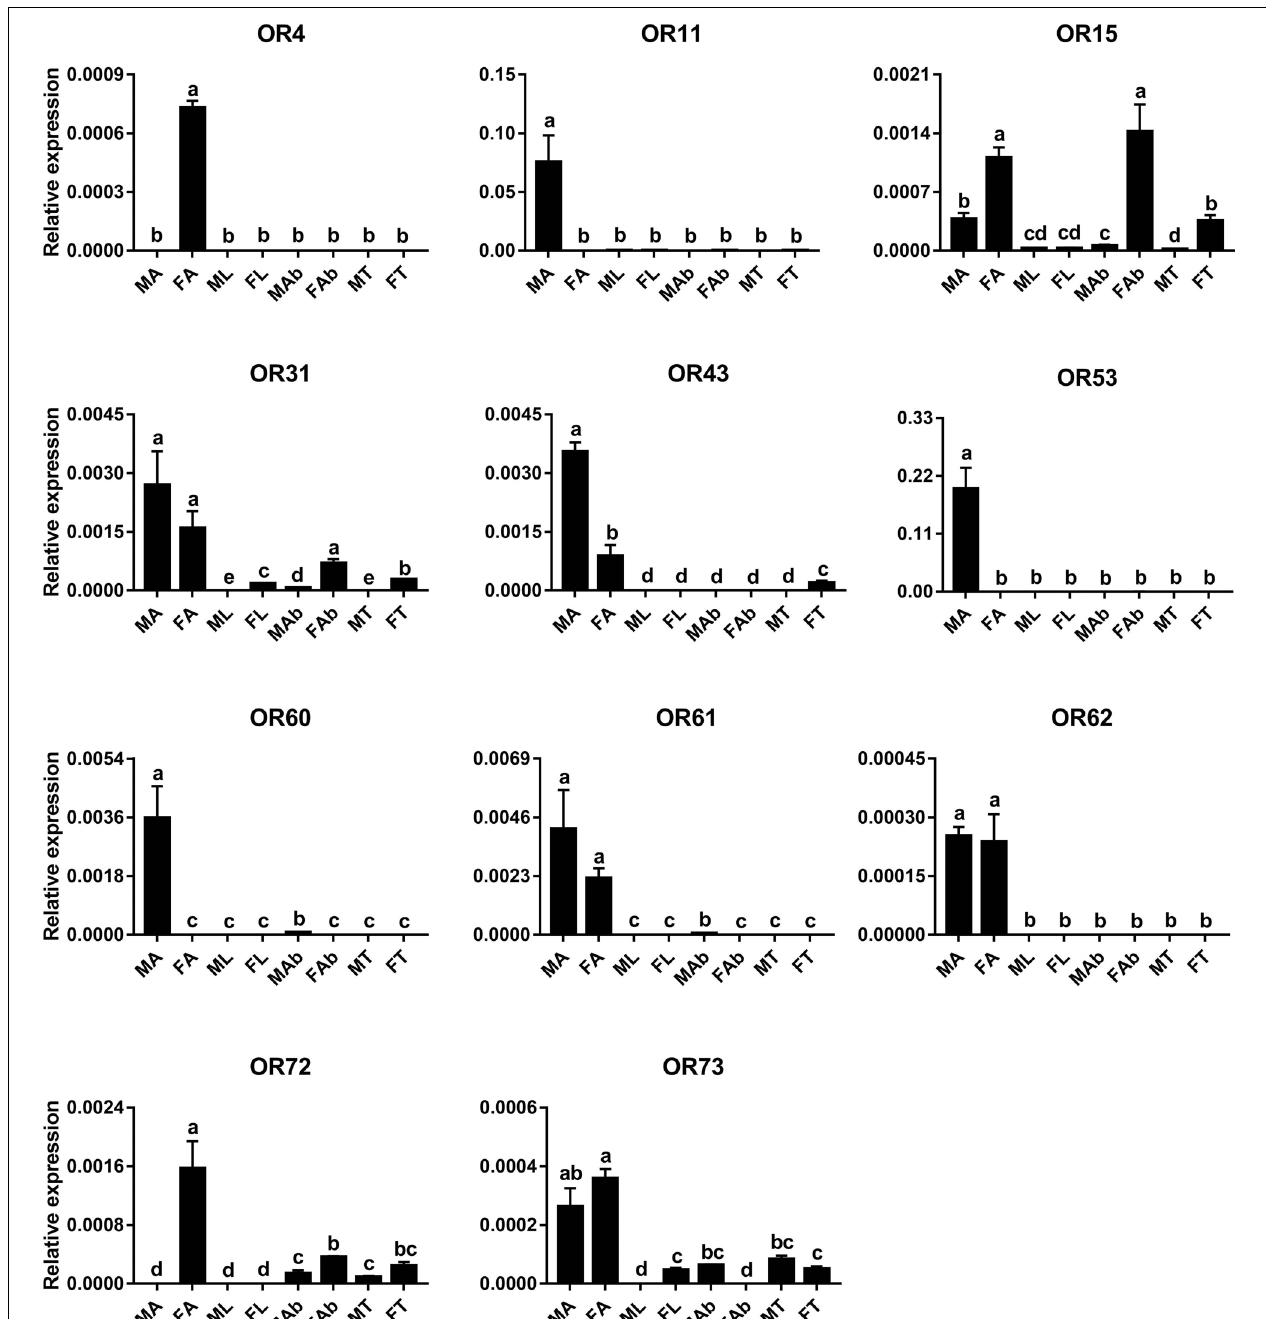
FIGURE 5 | Expression profile of candidate DabiPRs in different tissues of D. abietella . Significant difference of OR expression levels among tissues is indicated with different lowercase letters (ANOVA, LSD, P < 0.05). Relative expression of DabiORs was normalized relative to two reference genes, DabiRPS4 and DabiRPL8 . The full names of tissues are seen in Table 1